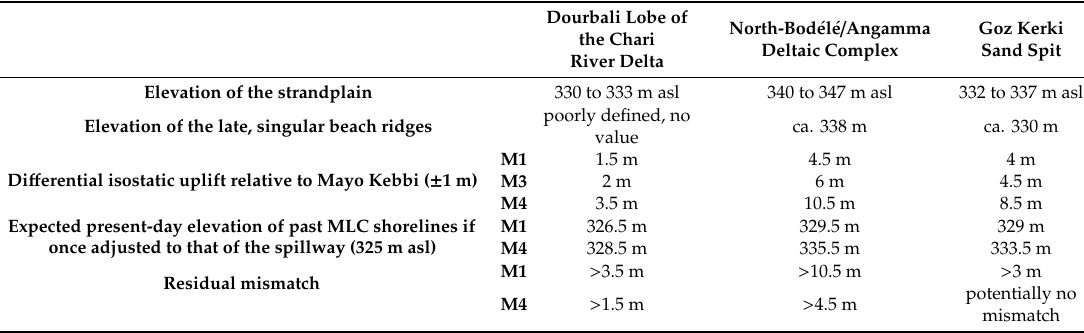
Table 2. Elevations of the paleo-shorelines of Megalake Chad at three key-areas, elevation correction according to the di ff erent Earth models relative to the Mayo Kebbi spillway, and expected present-day elevation of past MLC shorelines for a MLC set at the elevation of this